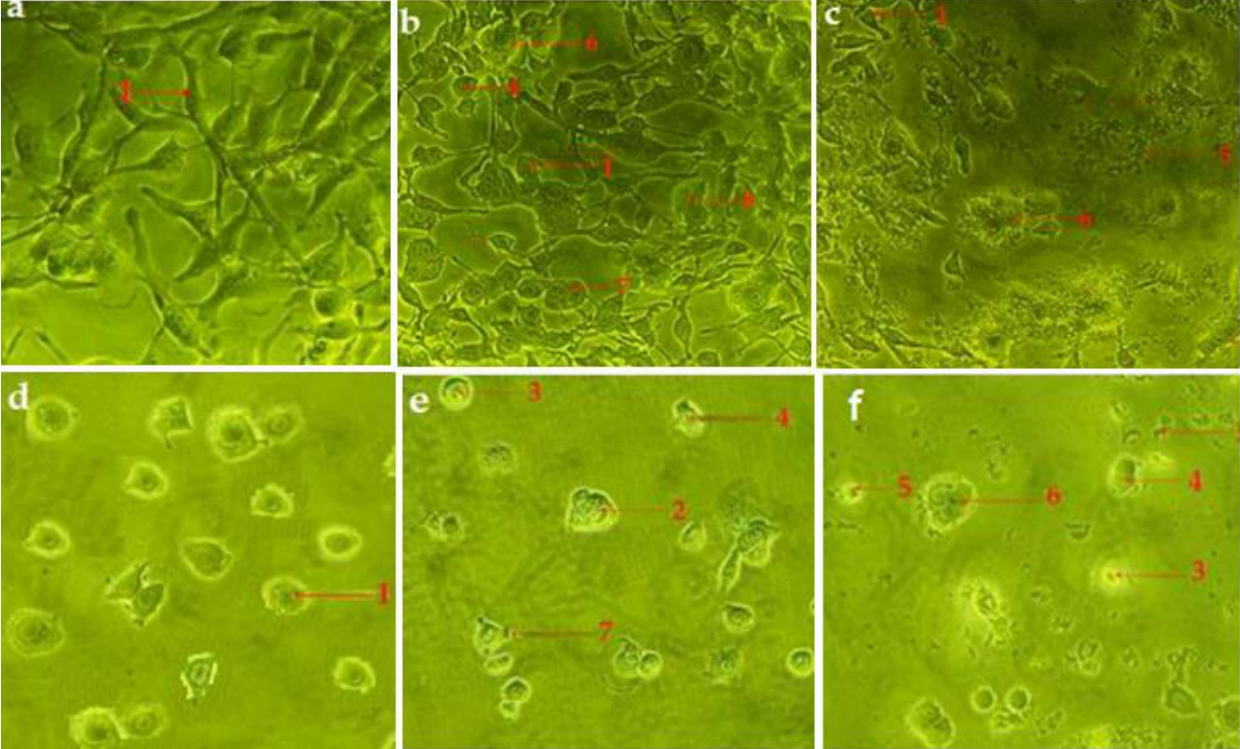
Figure 4. Photomicrographs exhibiting morphological changes of RMS and MCF-7 cancer cells. RMS cells treated with—( a ): control (untreated cells); ( b ): standard cycloheximide (15 μg/mL); ( c ): standard cycloheximide (30 μg/mL). MCF-7 cells treated with ( d ): control (untreated cells); ( e ): standard cycloheximide (15 μg/mL); ( f ): standard cycloheximide (30 μg/mL) for 24 h and imaged with a phase-contrast microscope (magnification 200×).